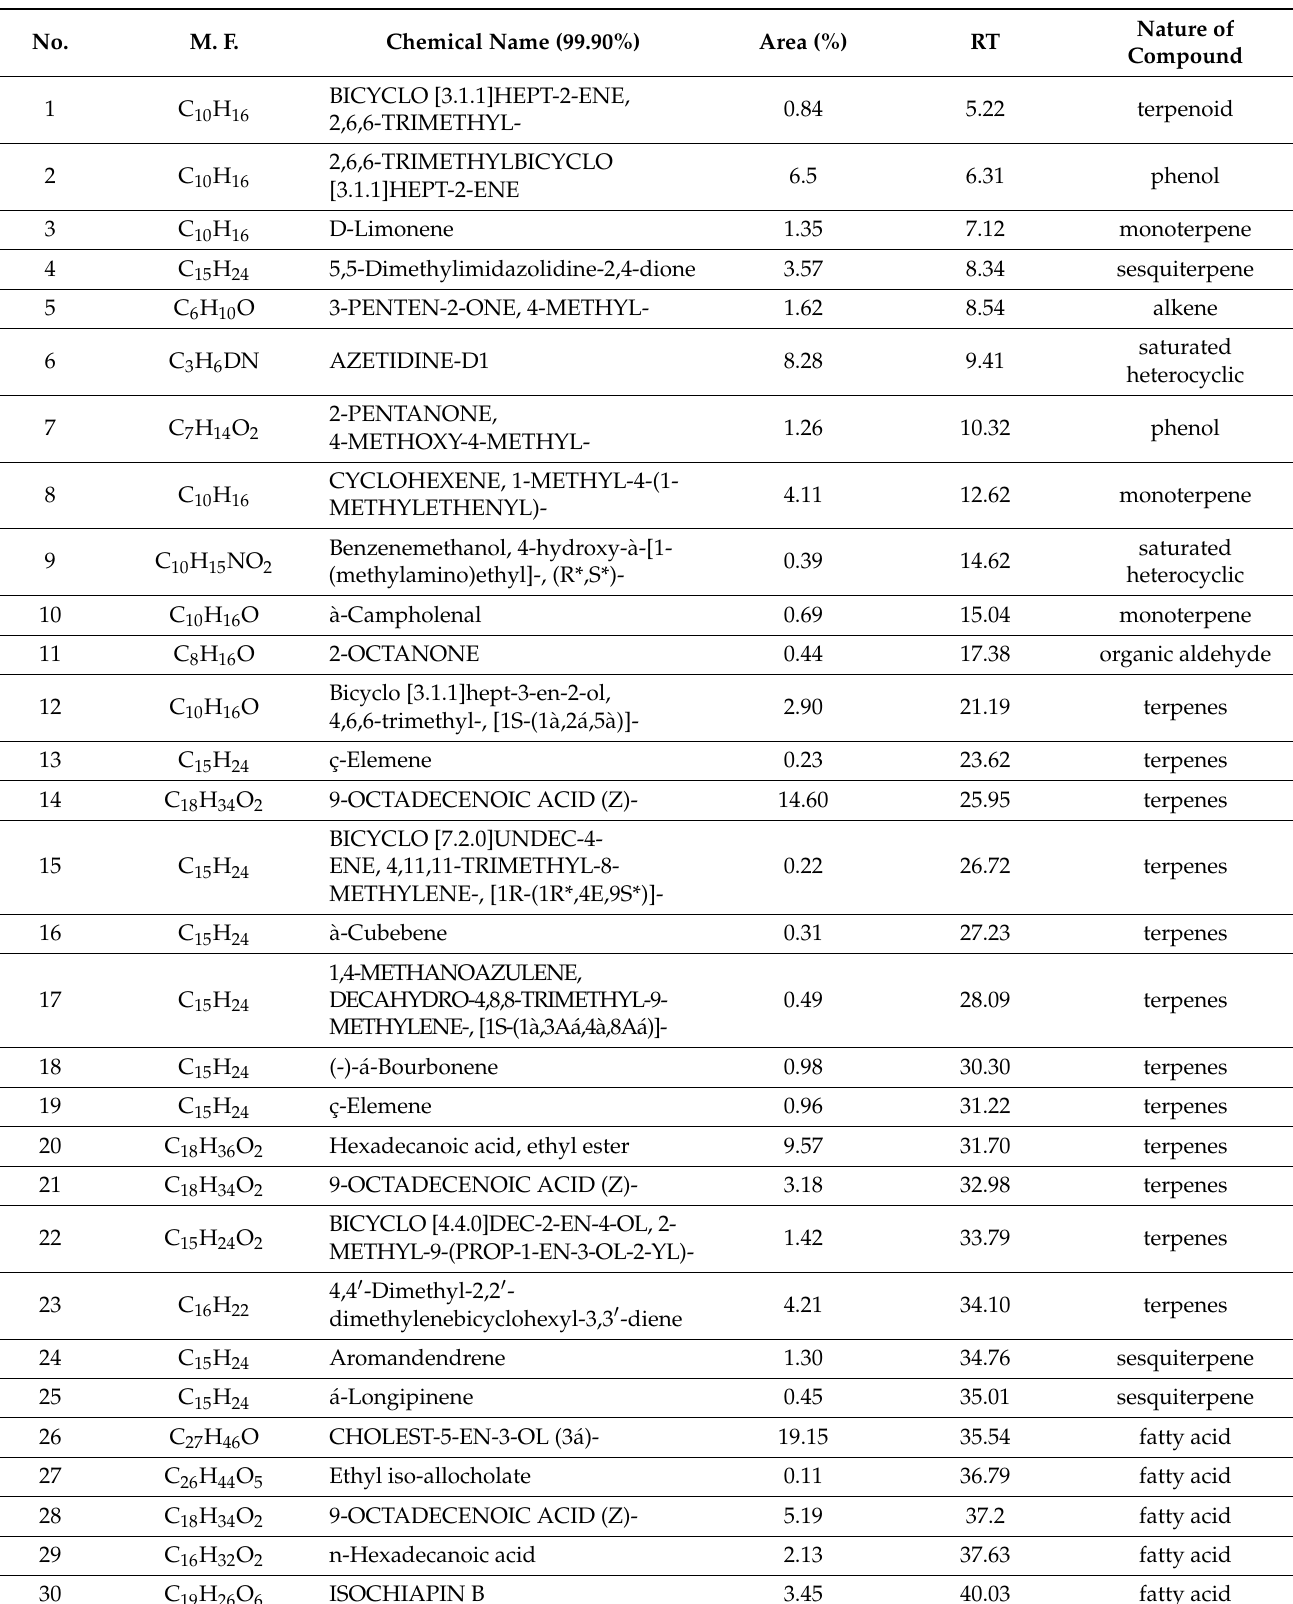
Table 12. The major chemical constituents of Araucaria heterophylla hexane